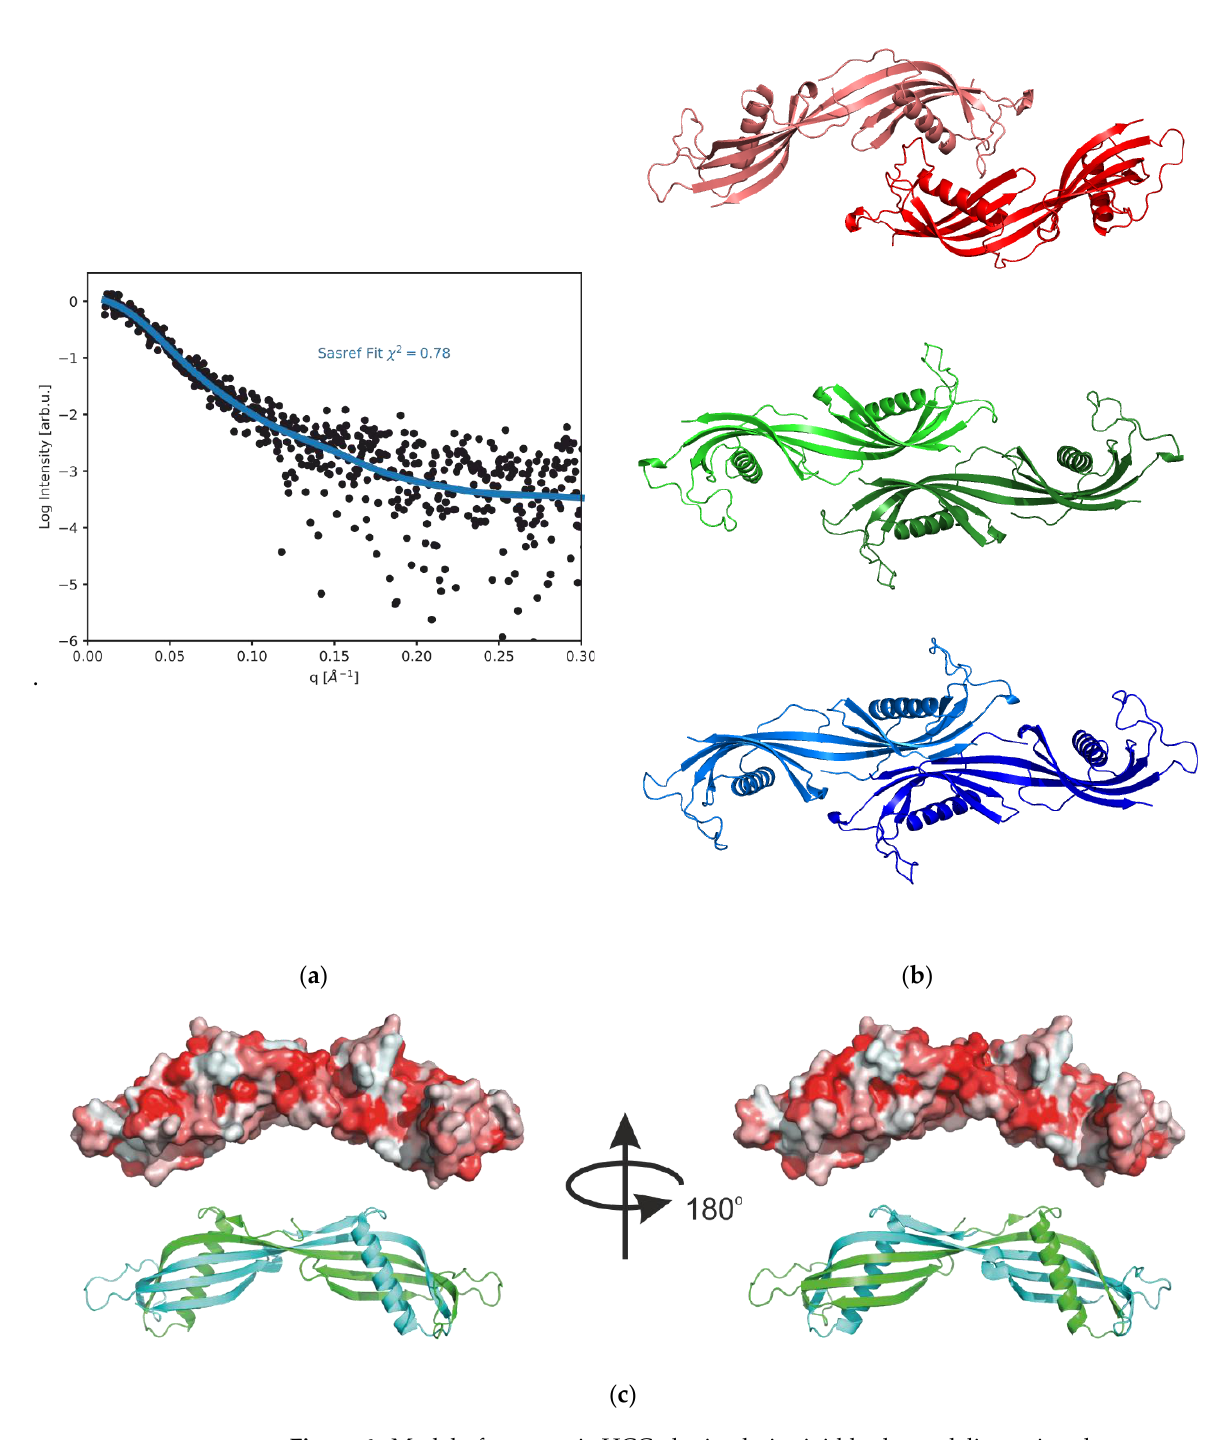
Figure 6. Model of tetrameric HCC obtained via rigid body modeling using the structure of the HCC dimer [10] and SAXS data: ( a ) the fit of the model to the experimental data for the selected SASREF run with the highest score; ( b ) three top models of the HCC tetramer obtained using SASREF; ( c ) the protein surface hydrophobicity (the more red color indicates higher hydrophobicity) (bottom) calculated for the domain-swapped HCC dimer.